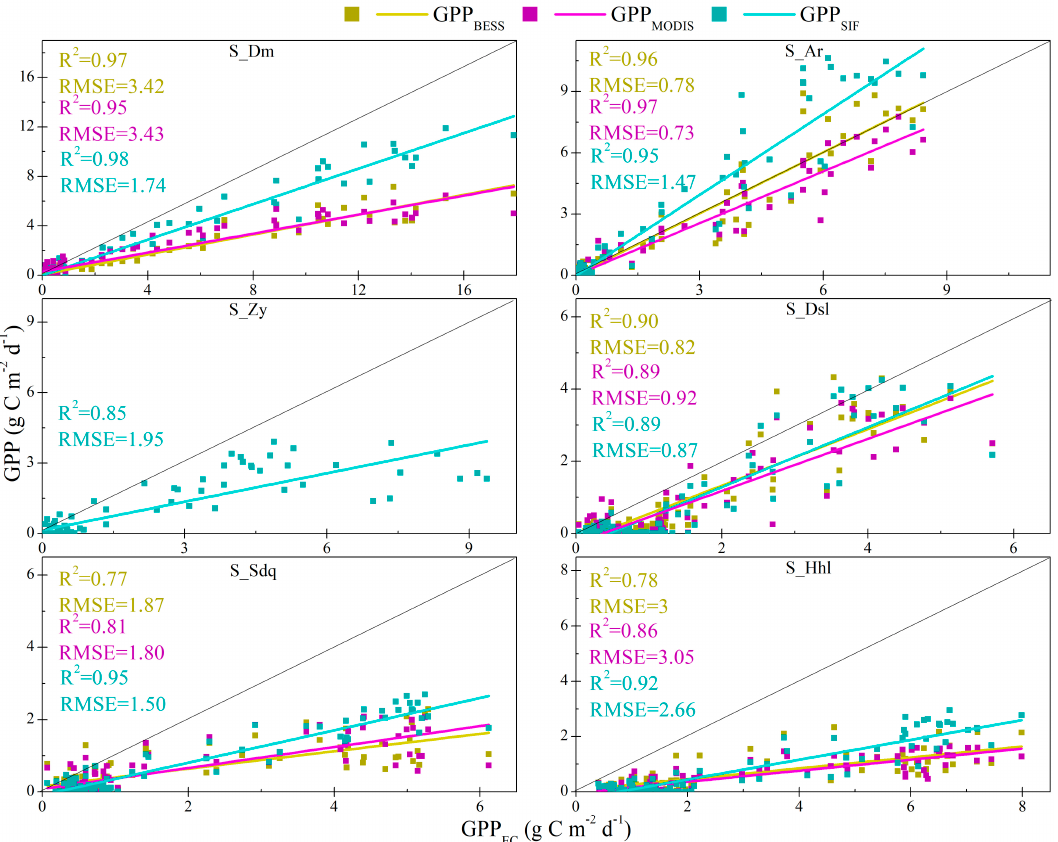
Figure 4. The scatter plots of the ecosystem GPP from flux measurements (GPP EC ) and GPP BESS , GPP MOD , and GPP SIF on the eight-day time scale at the six flux sites. The dotted line and solid line are used to show 1:1 line and linear fit,